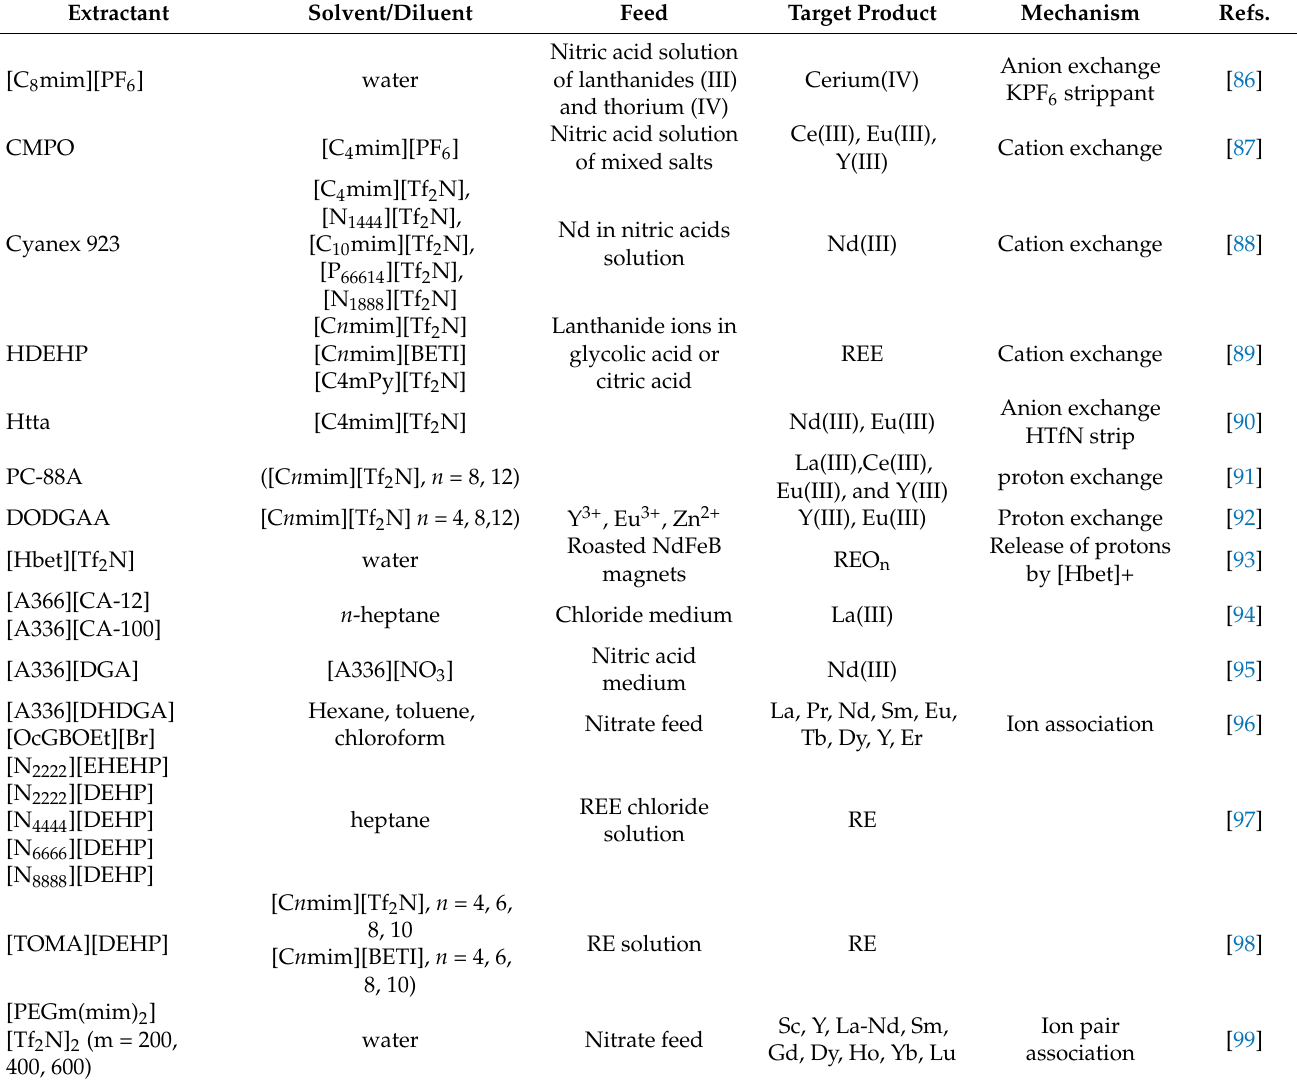
Table 5. Some selective findings summarized in “Recovery of rare earth elements with ionic liquids” review